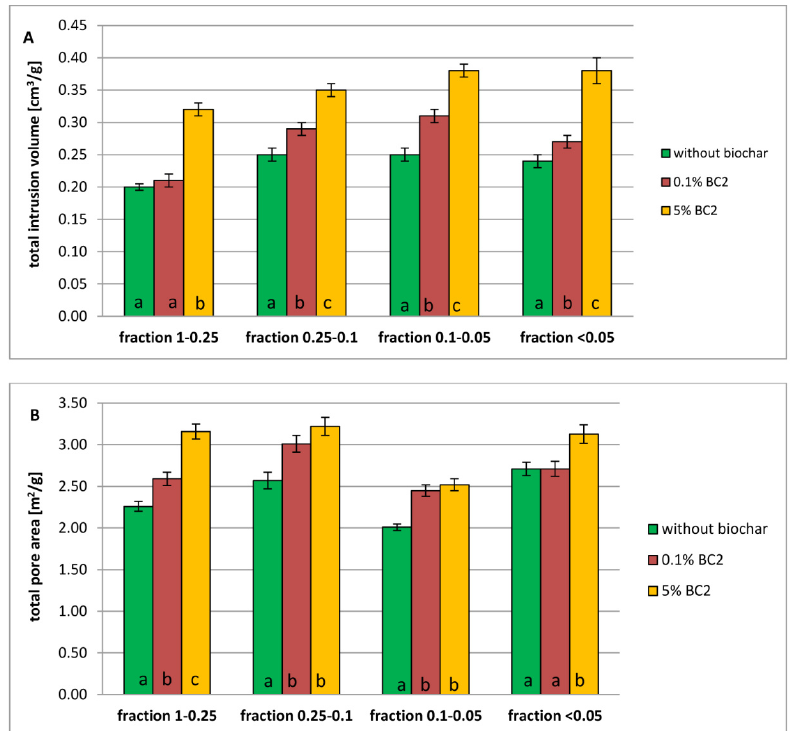
Figure 7. Porosity characteristics of the cylinders remolded using selected Dystric Cambisol fractions with and without sunflower husk biochar (BC2): ( A ) total intrusion volume, ( B ) total pore area; the bars correspond to the standard deviation. Agronomy 2020 , 10 , x FOR PEER REVIEW